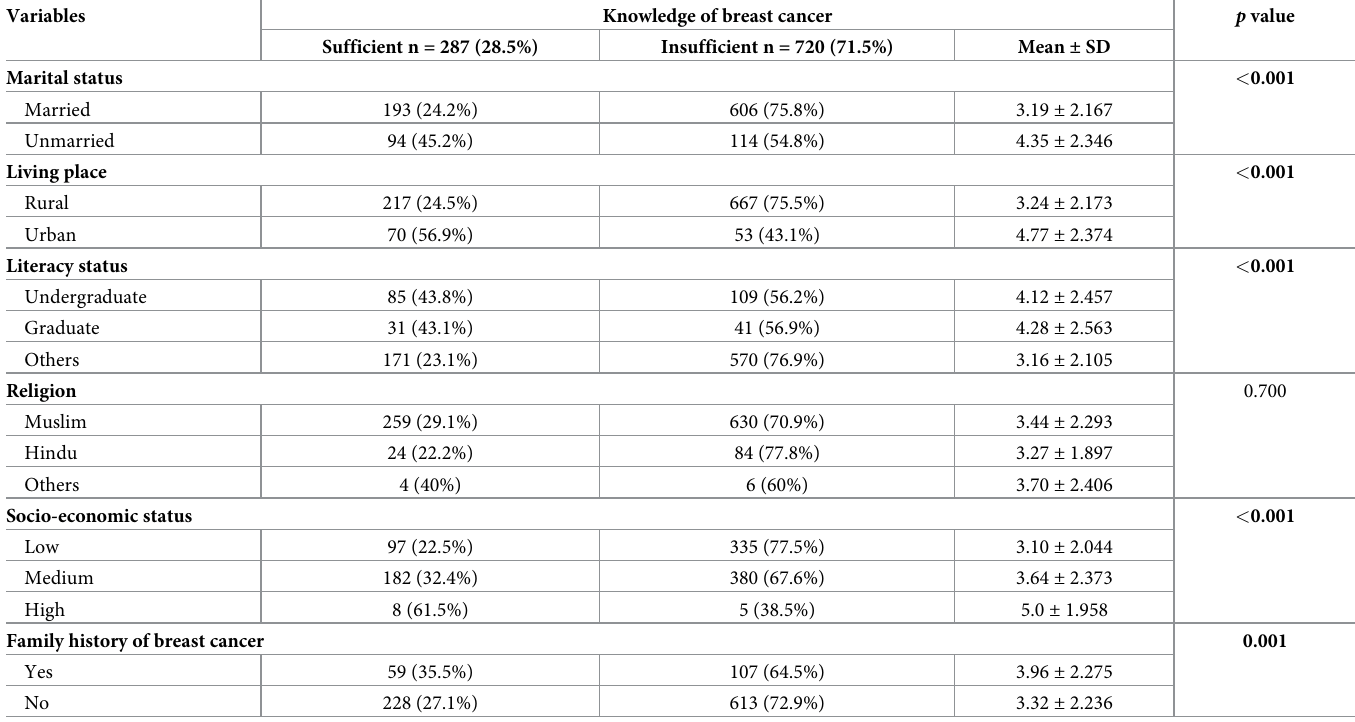
Table 3. Association between demographic variables and total breast cancer knowledge scores (n =